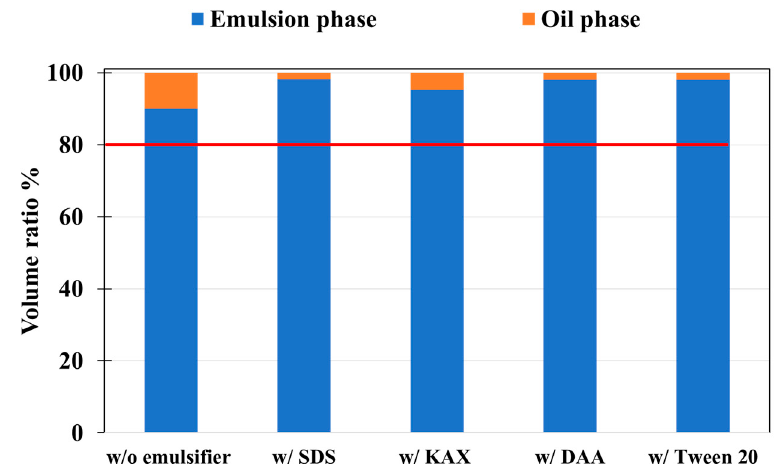
Figure 5. Volume ratio of oil and emulsion layers with and without emulsifiers after emulsification and centrifugation. Note that the red line indicates volume ratio without emulsification (80% water, 20% oil).